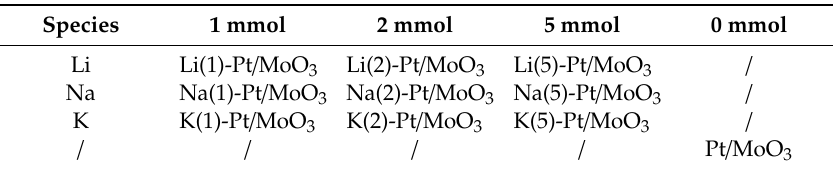
Table 1. Samples used in the experiment.